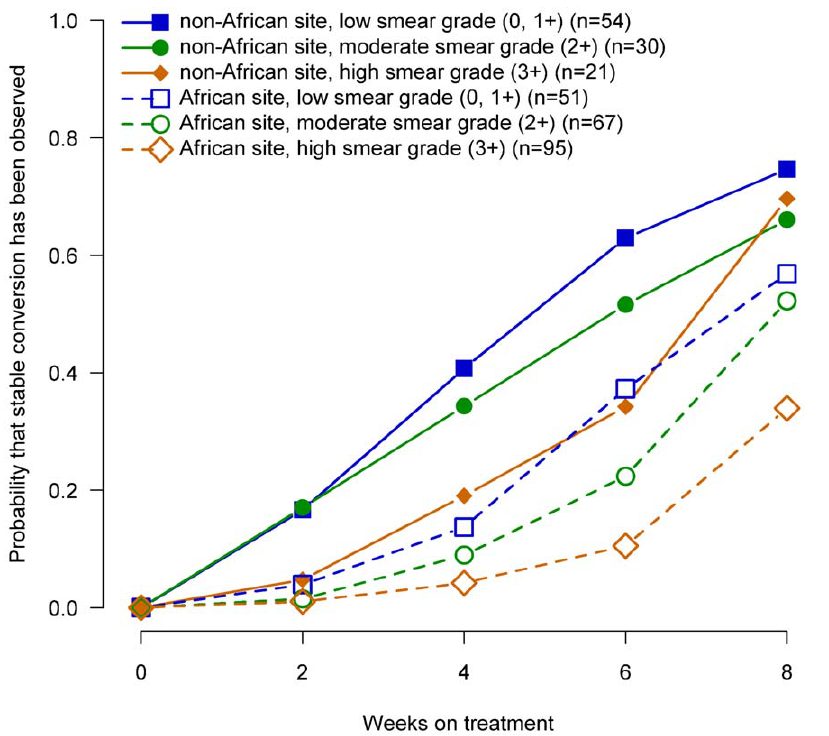
Figure 2. Probability of sputum culture conversion in liquid media by baseline sputum smear, African/non-African site and week of treatment, TBTC Study 28 protocol-correct patients.